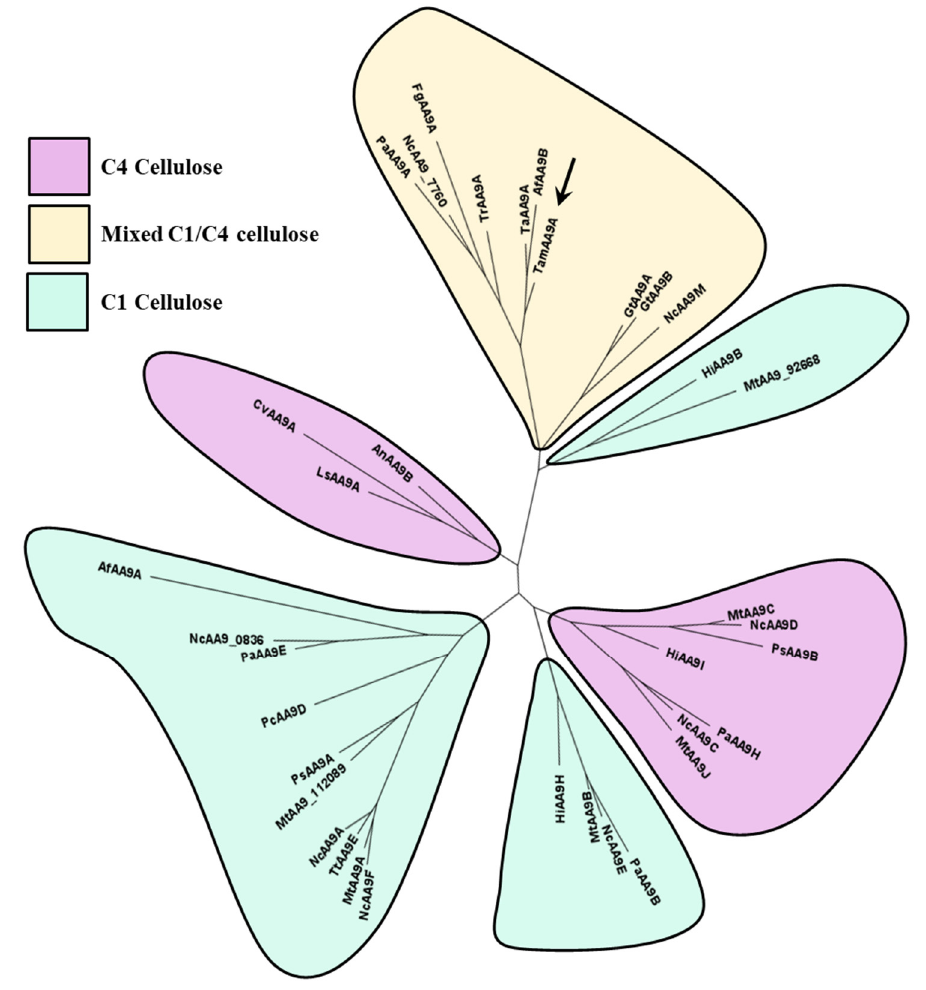
Figure 5. Cladogram built using the characterized AA9s in CAZy, after sequence alignment with MAFFT and tree building with PhyML. Af, Aspergillus fumigatus ; An, Aspergillus nidulans ; At, Aspergillus tamarii; Cv, Collariella virescens ; Fg, Fusarium graminearum ; Gt, Gloeophyllum trabeum ; Hi, Heterobasidion irregulare ; Ls, Lentinus similis ; Mt, Myceliophtora thermophila ; Nc, Neurospora crassa ; Pa, Podospora anserina ; Pc, Phanerochaete chrysosporium ; Ps, Pestalotiopsis sp.; Ta, Thermoascus auranticus ; Tam, Talaromyces amestolkiae ; Tr, Trichoderma reesei ; Tt, Thermothielavioides terrestris .